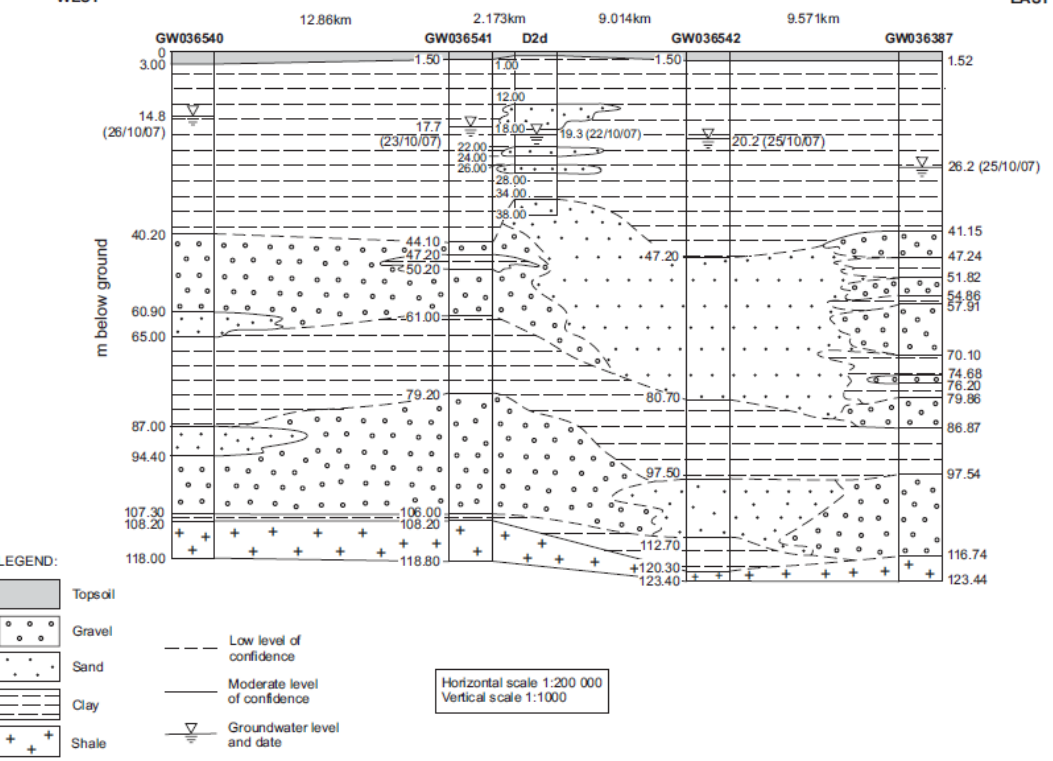
Fig. 4. Stratigraphic transect from west to east (location shown on Fig. 1), through the Denham monitoring piezometer site.